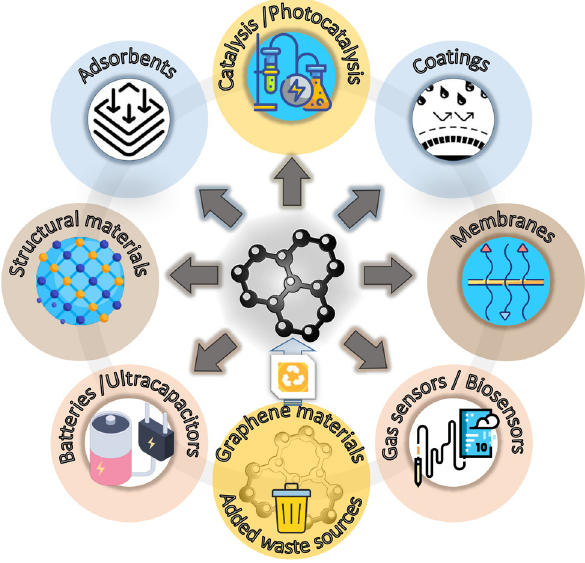
Figure 2: The most notable applications of waste - generated gra - phene - based nanocomposite materials.